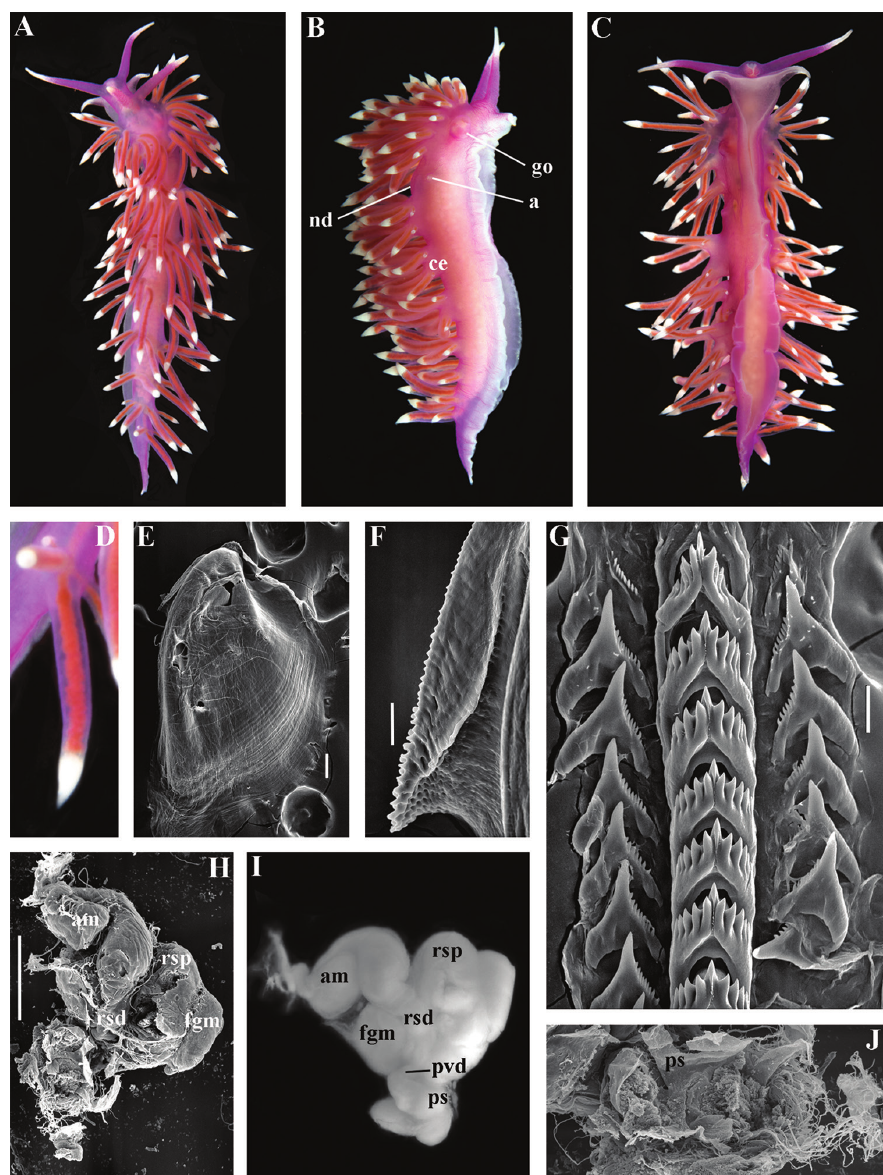
Figure 40. Edmundsella pedata (Montagu, 1815), comb. n. Norwegian Sea, Gulen Dive Center. ZMMU Op-540, living specimen 28 mm in length: A dorsal view B lateral view C ventral view D details of cerata E jaw, SEM F details of masticatory process of jaw, SEM G radular teeth, posterior part, SEM H reproduc- tive system SEM I reproductive system, light microscopy J penial sheath dissected. Abbreviations: a anus am ampulla ce ceratal elevations fgm female gland mass go genital opening nd discontinuous notal edge ps penial sheath pvd prostatic vas deferens rsd distal receptaculum seminis rsp proximal receptaculum seminis. Scale bars: E, H, J = 100 μm; F = 20 μm; G = 50 μm. Photos and SEM images by T.A. Korshu- nova, A.V.